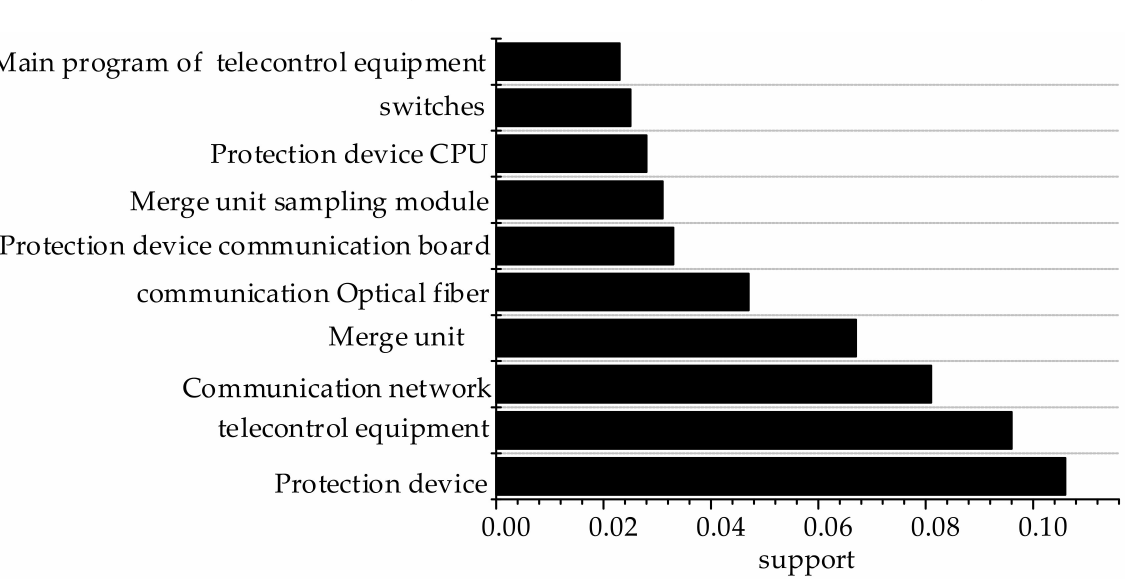
Figure 5. Support of each